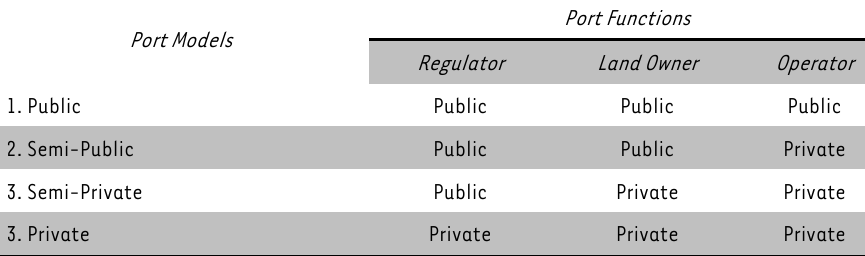
TABLE 2: Port Governance